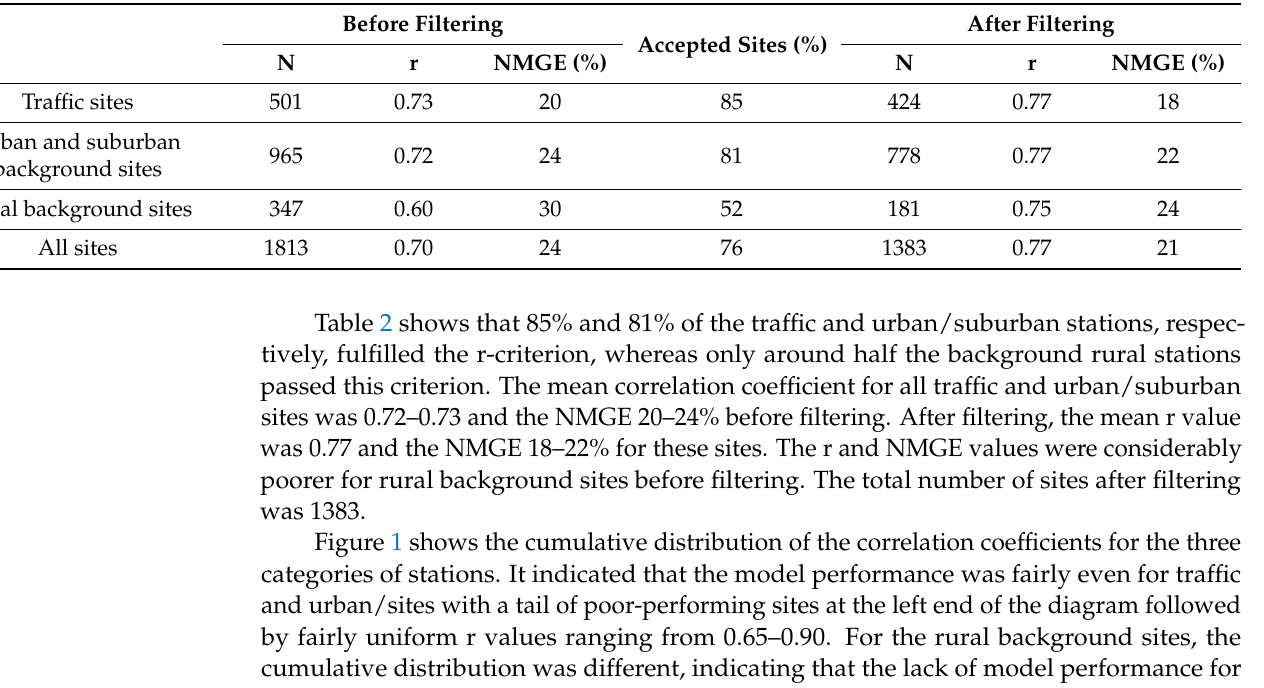
Table 2. Statistical performance metrics for the GAM vs. daily mean concentrations of NO 2 for March–July 2015–2019 for the three categories of stations. n = number of stations, r = linear correlation coefficient, NMGE = normalised mean gross error. The fraction of sites passing the screening (r > 0.65) is also